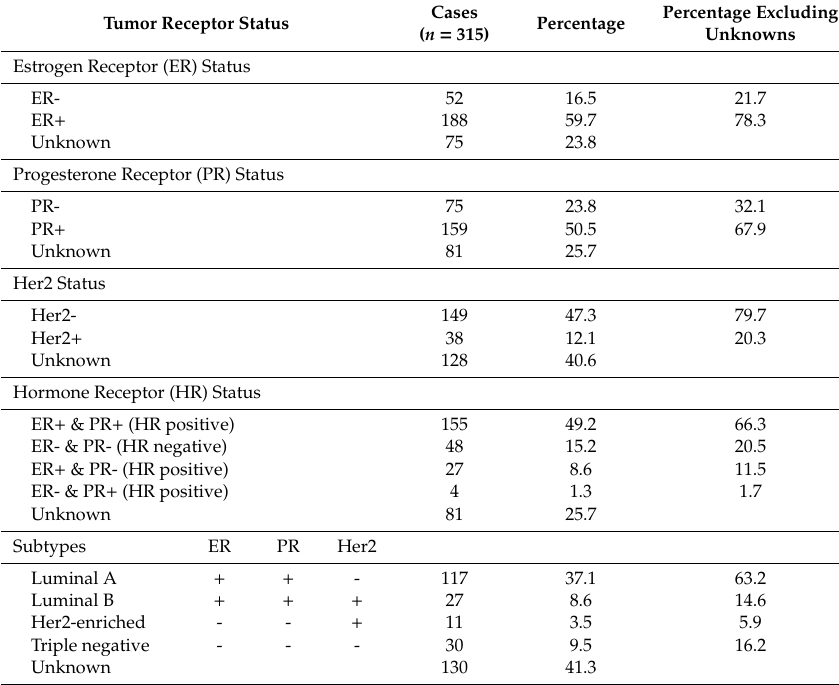
Table 2. Breast cancer types and subtypes in the Atabey